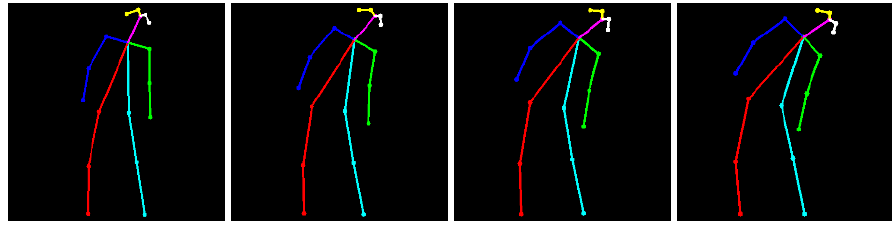
Figure 4. Some samples of different limb positions corresponding to the same human pose: right